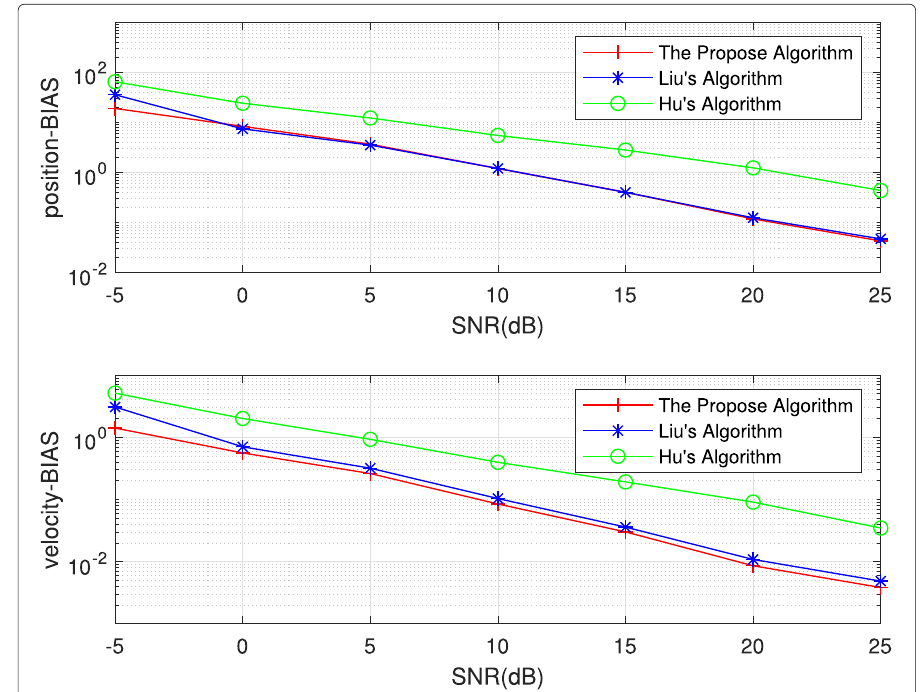
Fig. 2 Bias comparison of three algorithms for the near field source